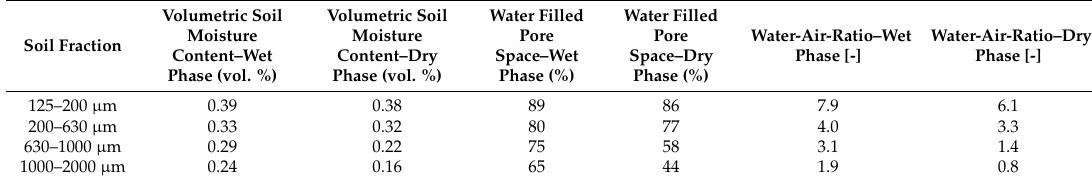
Table 3. Parameters of water